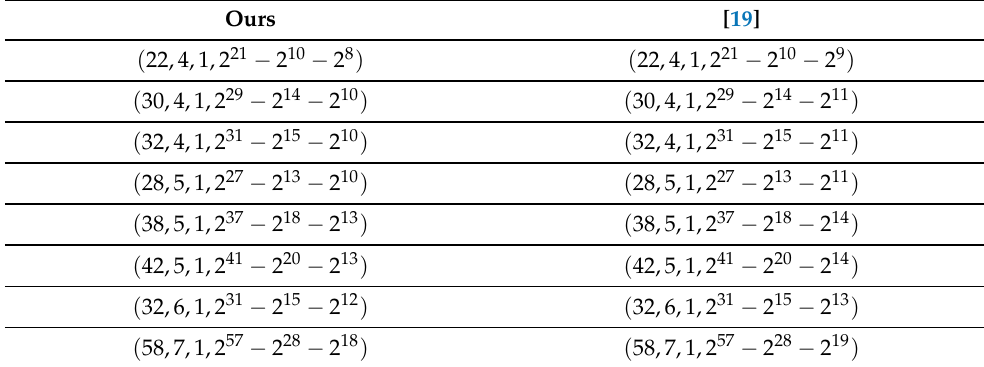
Table 1. ( n , m , t , N F ) S-boxes with higher nonlinearity than [19].